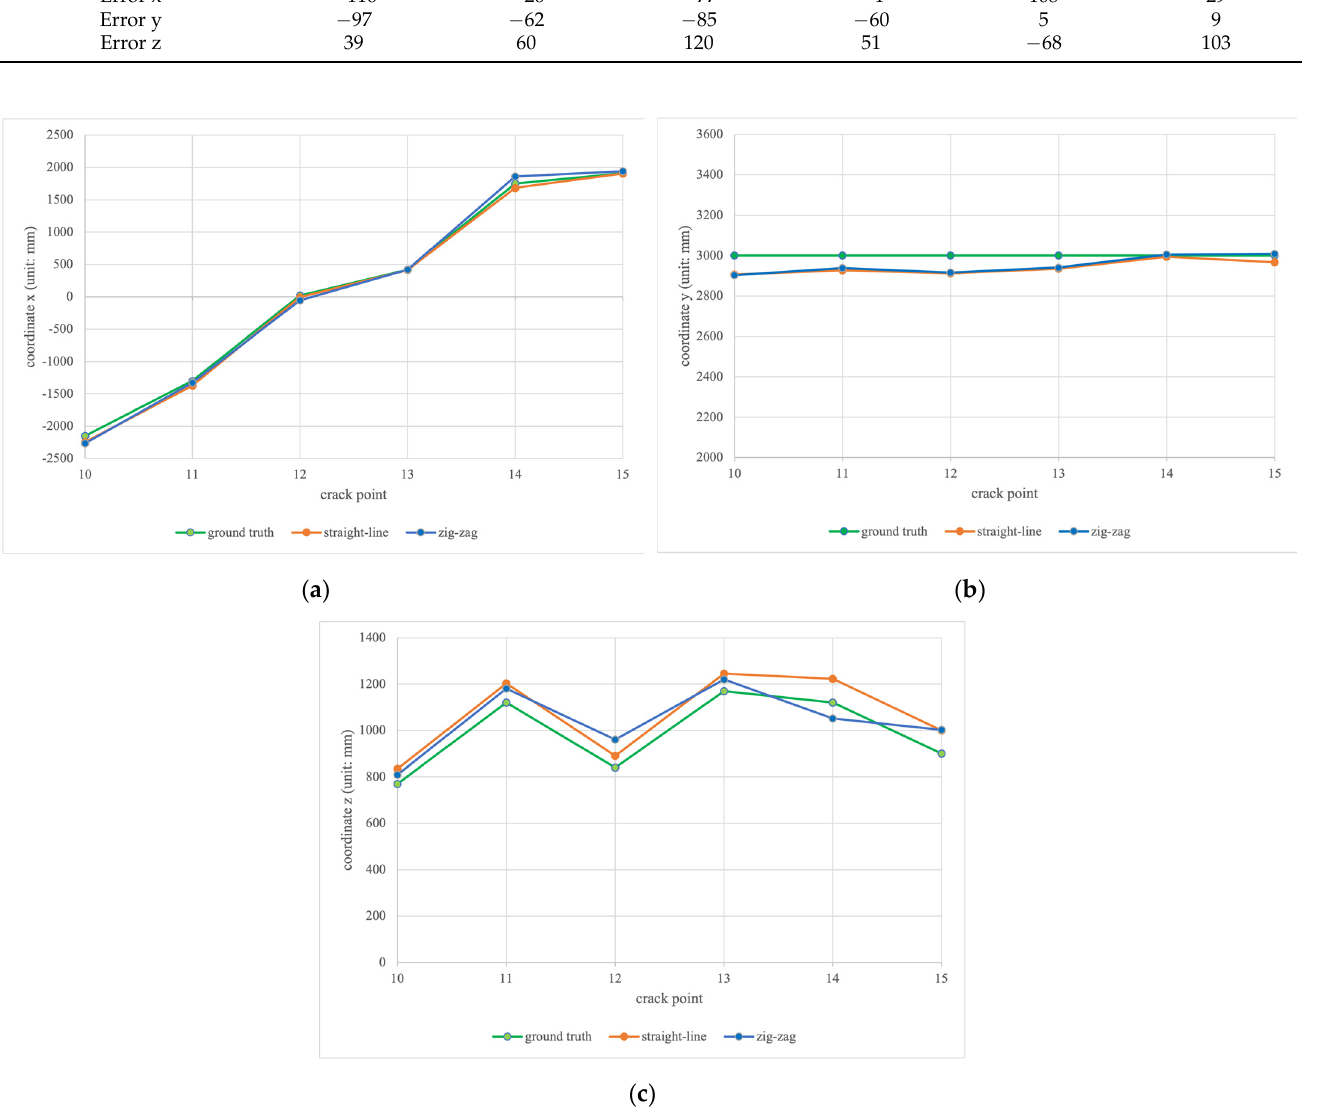
Figure 20. The localization results of ( a ) x coordinates; ( b ) y coordinates; ( c ) z coordinates on the unseen cracks.